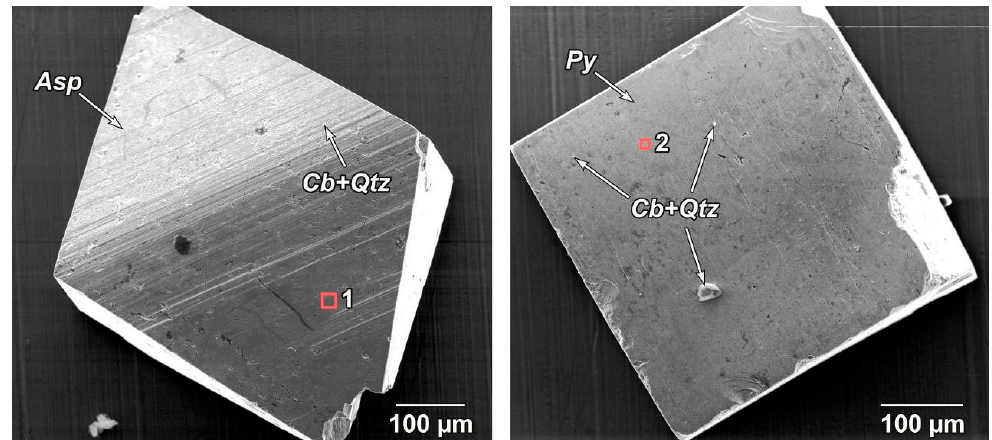
Figure 9. Crystals of arsenopyrite (Asp) and pyrite (Py) with microinclusions of carbonate (Cb) and quartz (Qtz). Surface areas of arsenopyrite (1) and pyrite (2) crystals, where measurements were carried out. Their enlarged fragments are shown in Figure 10.